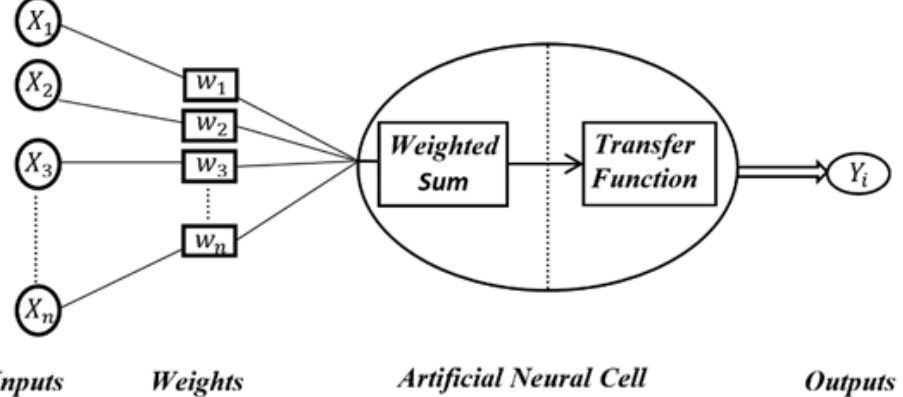
Figure 4. Structure of an artificial neural network.